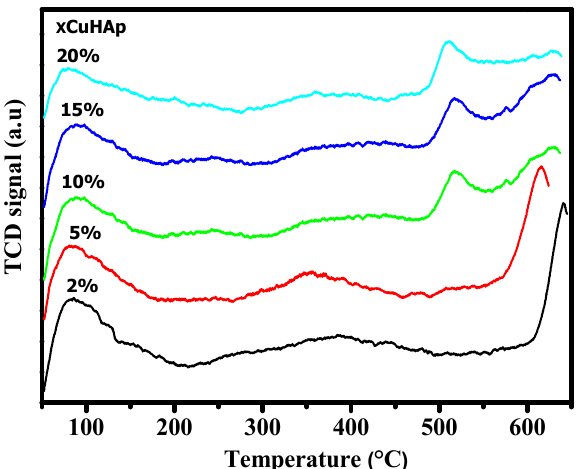
Figure 5. CO 2 -TPD profiles of CuHAp catalysts with different Cu loadings.